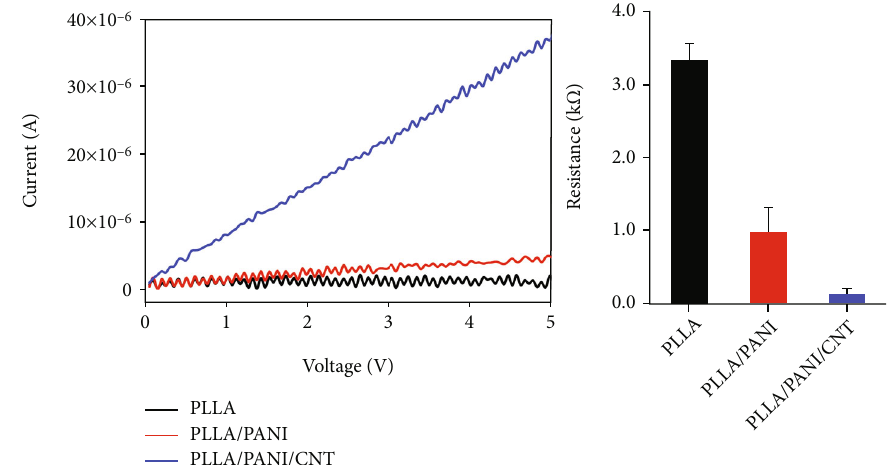
Figure 4: Current-voltage plots recorded for PLLA, PLLA/PANI/CNT, and PLLA/PANI-based nano fi ber sca ff olds. Electrical resistance is also calculated and plotted. The presented data are expressed as mean ± SD ( n = 3 ).